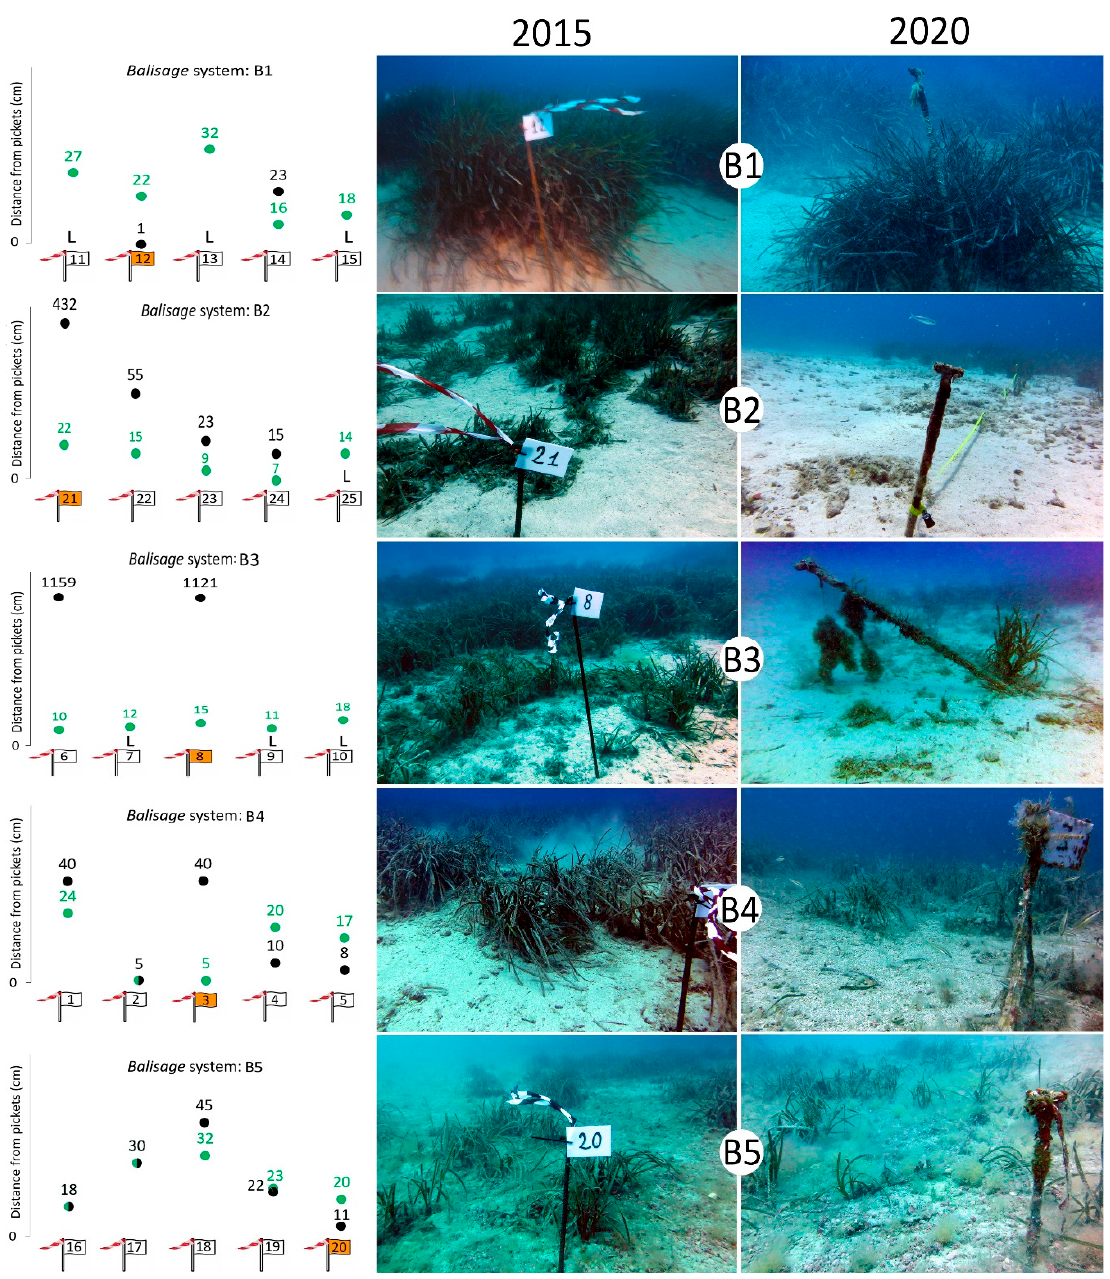
Figure 5. Graphic illustration of the distances between each picket and Posidonia oceanica in 2015 (green dots) and 2020 (black dots), with relative distances in cm. The orange flags represent the pickets shown on the right, as example of one of the five pickets at each balisage system. L: picket lost in 2020.